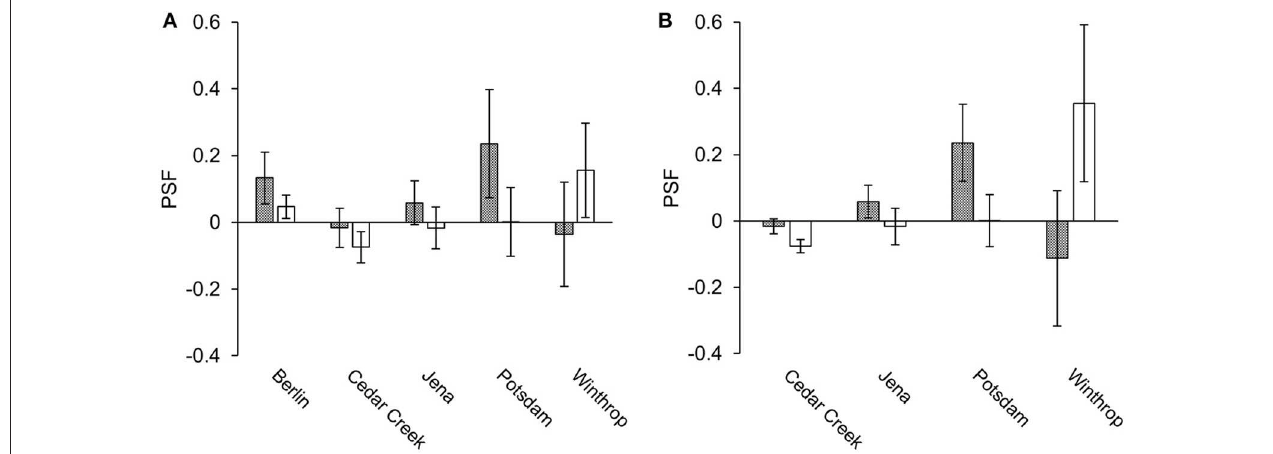
FIGURE 2 | Average greenhouse- and field-measured species-level (A) and species*soil-level (B) PSF values (mean ± SE). Gray indicates greenhouse studies and white indicates field